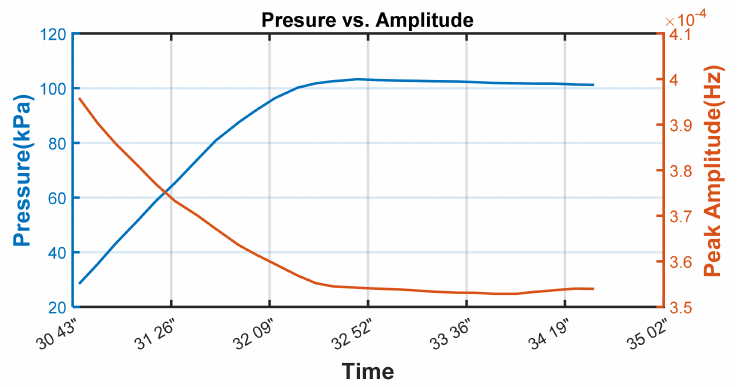
Figure 8. Comparison between pressure and amplitude of the major peak (test 2).